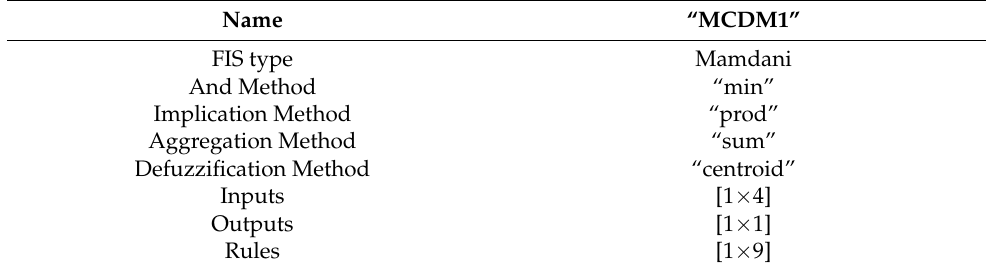
Table 8. Properties of fuzzy inference system to calculate